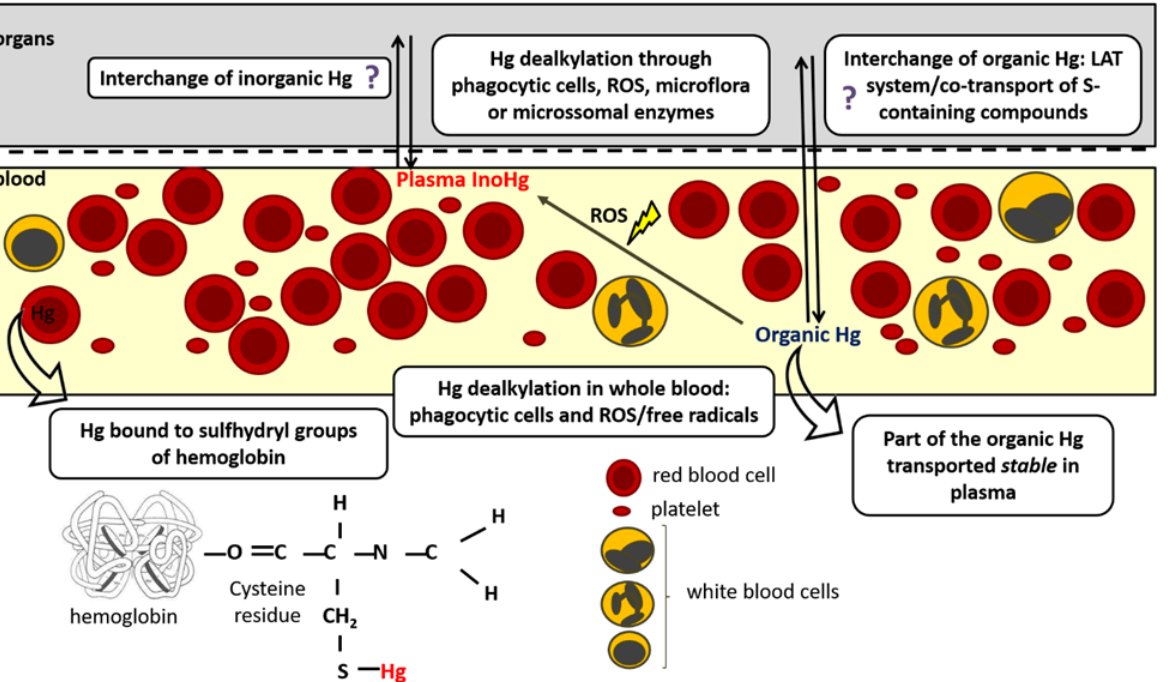
Figure 2. Main (and potential) processes involved in mercury dealkylation and transport between blood and organs. Organomercurial dealkylation is mediated in vivo by the intestinal microflora, microsomal enzymes as well as phagocytic cells (polymorphonuclear leukocytes, monocytes and macrophages). Conversion of organic Hg into InoHg can also occur through ROS and free radical formation. This conversion is known to occur far more rapidly in blood than in plasma — a likely less oxidative environment where organomercurials can be transported unmodified. Once in whole blood, EtHg (and potentially MeHg) can either bind to Hb cysteine residues and be converted into InoHg, be translocated and kept held unchanged in tissues, or be returned to plasma/red blood cells (based on [34] and [74]) findings). Question mark indicates processes that need to be proven (poten- tial).